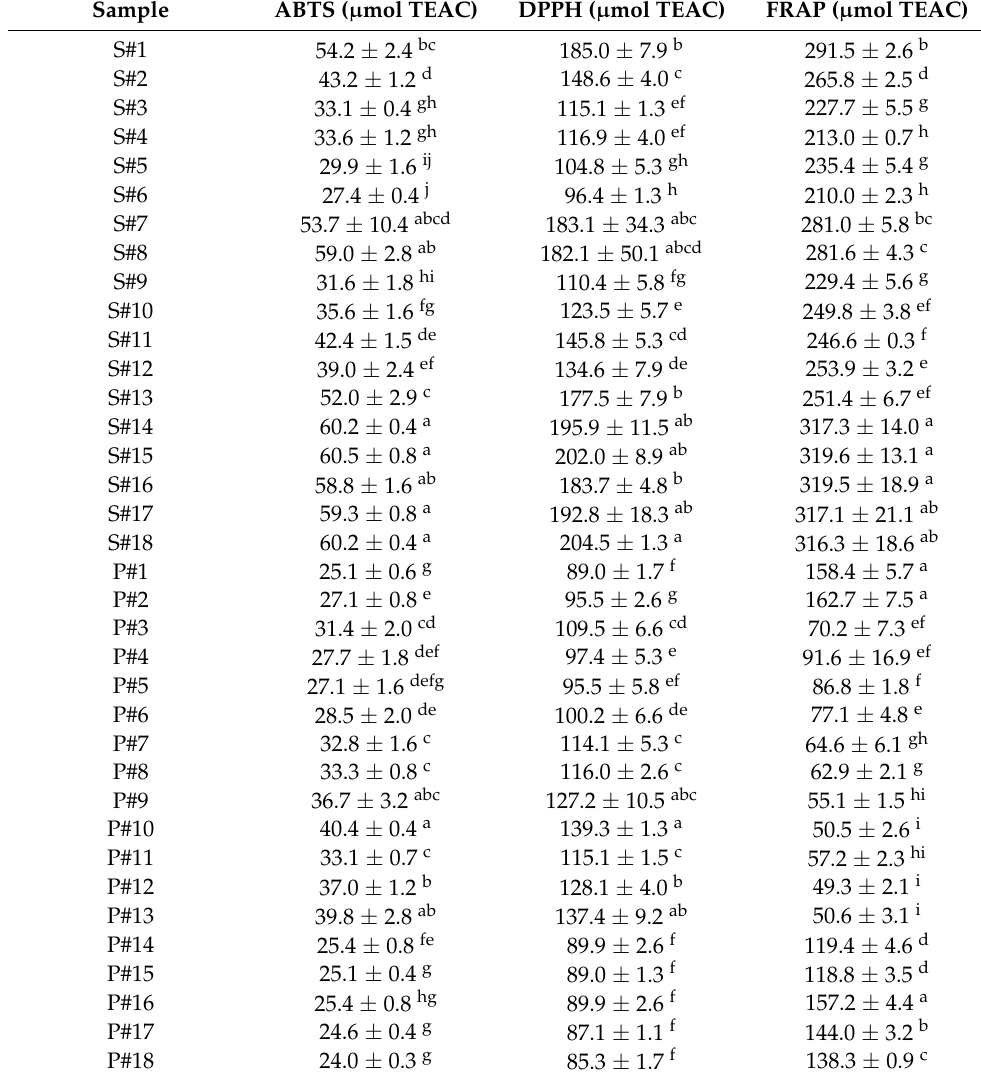
Table 3. In vitro cell-free antioxidant activity of the stamen and perianth extracts of 18 N. nucifera populations originating from various floristic regions from